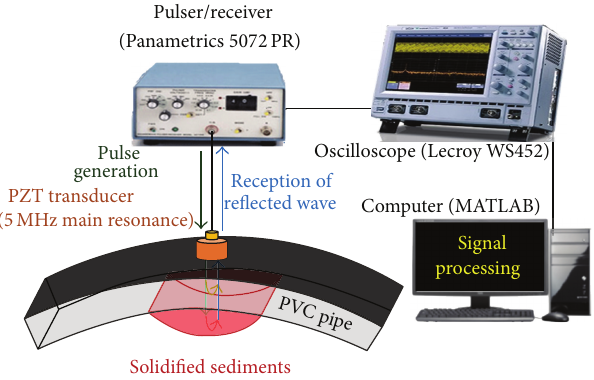
Figure 4: Pulse-echo ultrasonic inspection for PVC